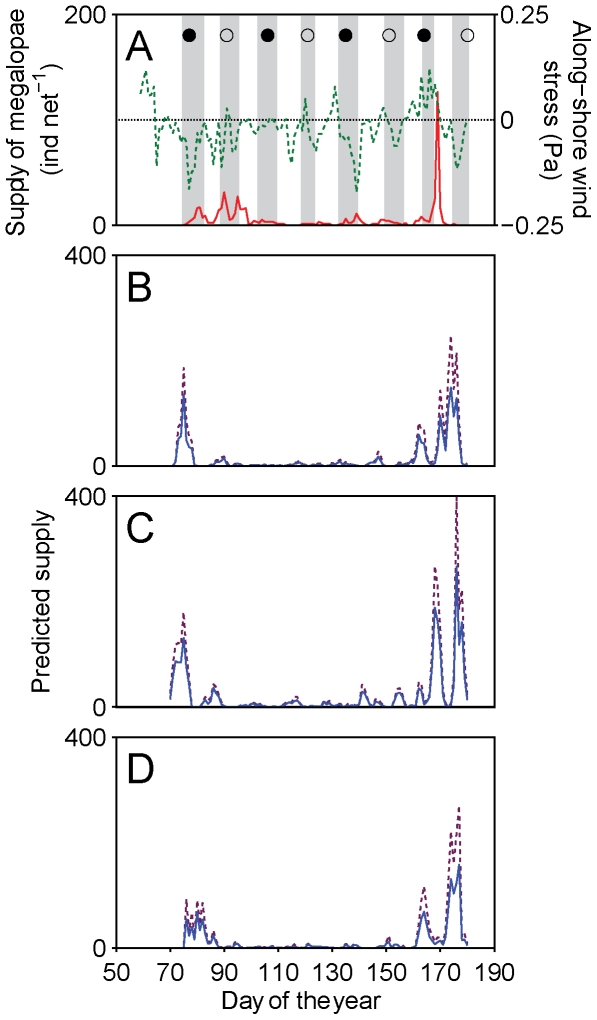
Observed and predicted time series of supply in 2007.(A) Daily numbers of observed megalopal supply (continuous line), along-shore wind stress (dashed line) and spring tides (tidal range larger than long-term average range, grey bars) in the Ria de Aveiro in 2007; and predicted time series of supply by the Invasion experiments with (B) normal, (C) fast and (D) slow growth rates with (dashed line) and without (continuous line) mortality, for the same year.